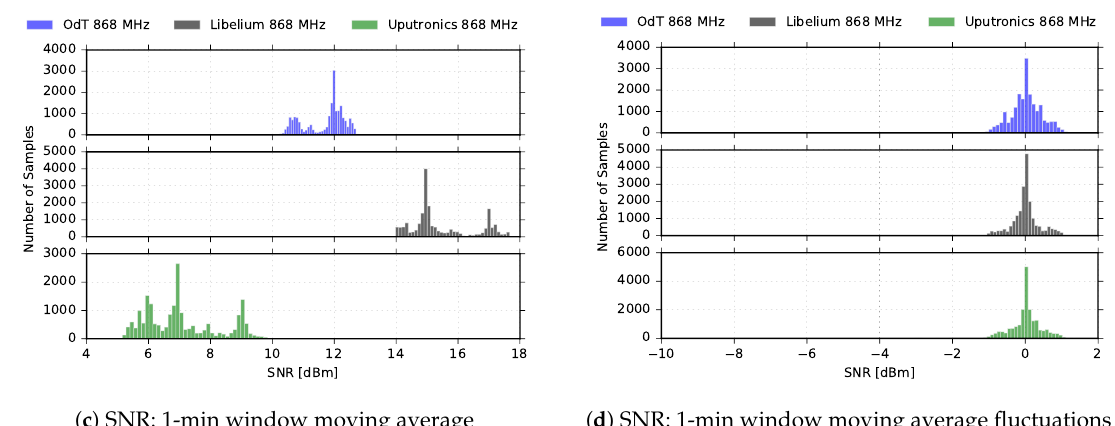
Figure 12. RSS and SNR histograms for ODT, Uputronics and Libelium: f = 868MHz, BW = 125kHz, SF = 10, CR = 4/6,